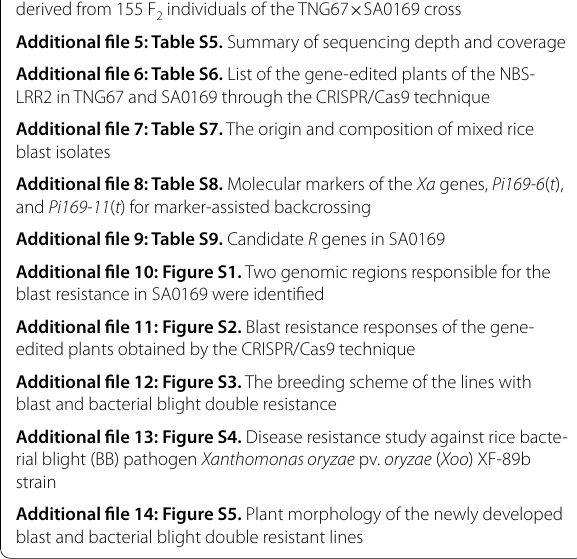
Additional file 5: Table S5. Summary of sequencing depth and